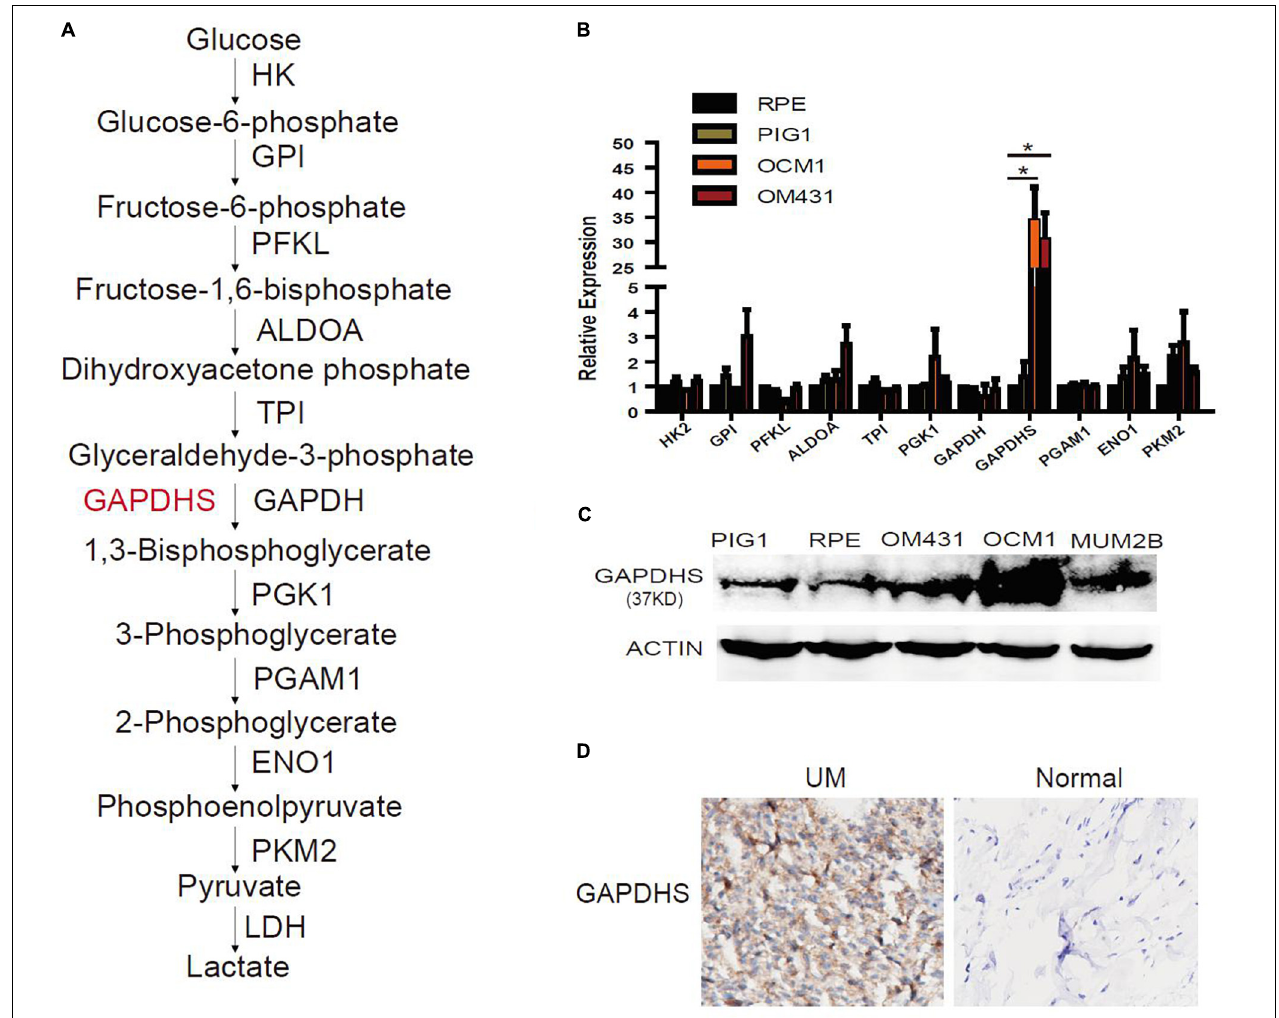
FIGURE 1 | Aberrant expression of glyceraldehyde-3-phosphate dehydrogenase (GAPDHS) in melanoma. (A) Glycolysis enzymes involved in the glycolytic pathway. HK, hexokinase; GPI, glucose-6-phosphate isomerase; PFKL, phosphofructokinase liver type; ALDOA, aldolase A; TPI, triosephosphate isomerase; PGK1, phosphoglycerate kinase 1; GAPDH, glyceraldehyde-3-phosphate dehydrogenase; PGAM1, phosphoglycerate mutase 1; ENO1, enolase 1; PKM2, pyruvate kinase M2. (B) Glycolysis enzyme expression was determined by real-time qPCR in melanoma cell lines, and values are given as the mean ± SE. HK2, hexokinase 2; GPI, glucose-6-phosphate isomerase; PFKL, phosphofructokinase liver type; ALDOA, aldolase A; TPI, triosephosphate isomerase; PGK1, phosphoglycerate kinase 1; GAPDH, glyceraldehyde-3-phosphate dehydrogenase; PGAM1, phosphoglycerate mutase 1; ENO1, enolase 1; PKM2, pyruvate kinase M2. ∗ P < 0.05 compared with the normal control group. ARPE-19 and PIG1 cells were used as normal controls. (C) Protein levels of GAPDHS were determined by western blot in OCM1 and OM431 cells. Actin served as the loading control. ARPE-19 and PIG1 cells were used as normal controls. (D) GAPDHS expression in 10 uveal melanoma tissues and 10 normal tissues by immunohistochemistry